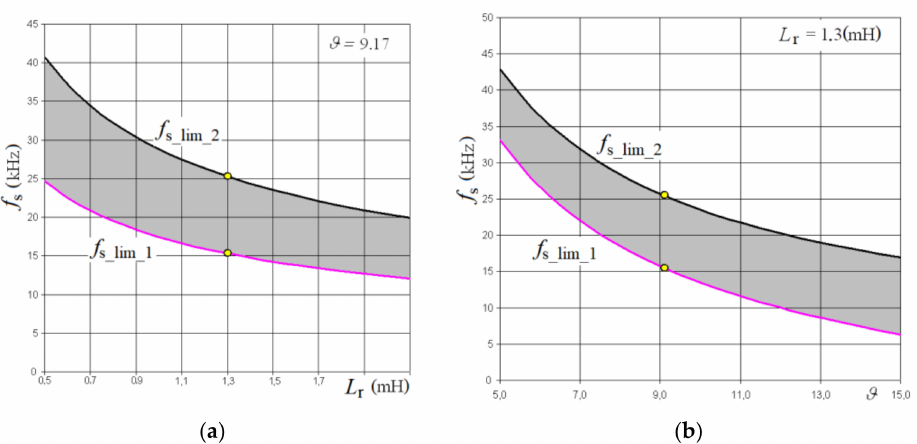
Figure 6. The range of the inverter output frequency at which the discharges appear (derived by mathematical analysis) as a function of: ( a ) inductance L r ; ( b ) transformer windings ratio, reproduced from Przegl ˛ad Elektrotechniczny [34].